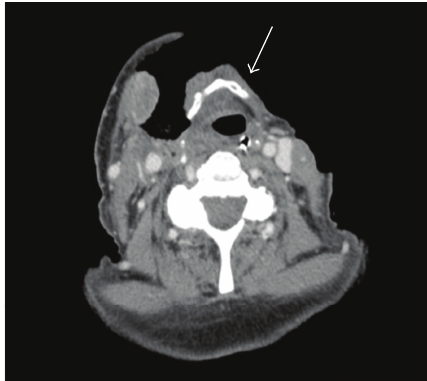
Figure 3: Postoperative CT scan at level of the hyoid. Note: the extensive loss of soft tissue in the anterior neck compartment (arrow).